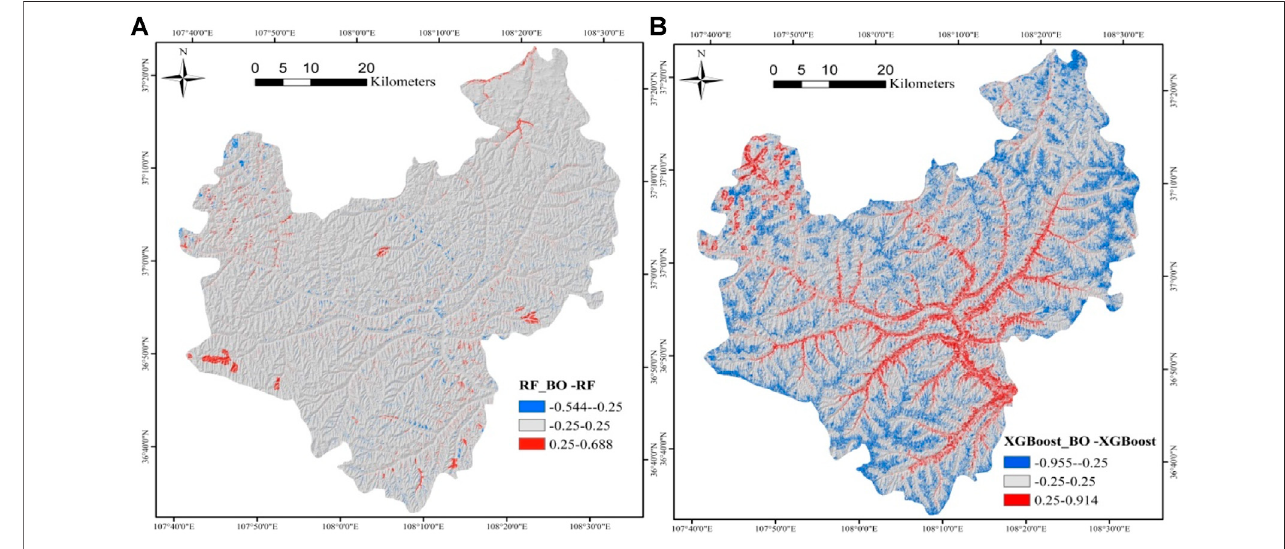
FIGURE 9 | Two comparison maps. (A) RF_BO-RF, (B) XGBoost_BO-XGBoost.